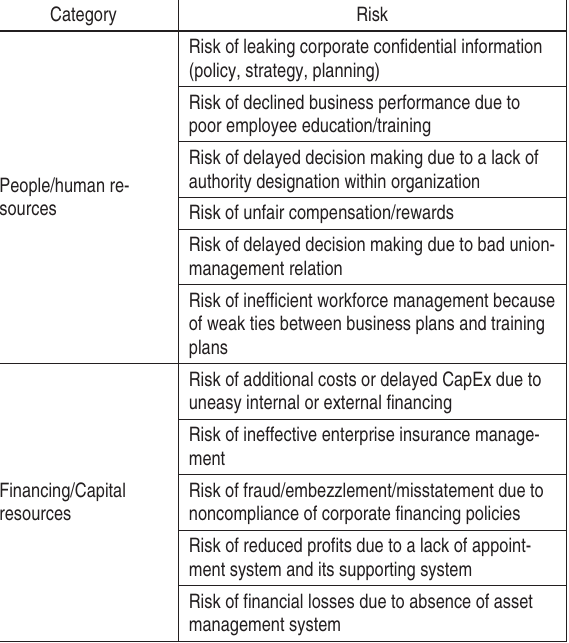
Table 2. Risk profile of company